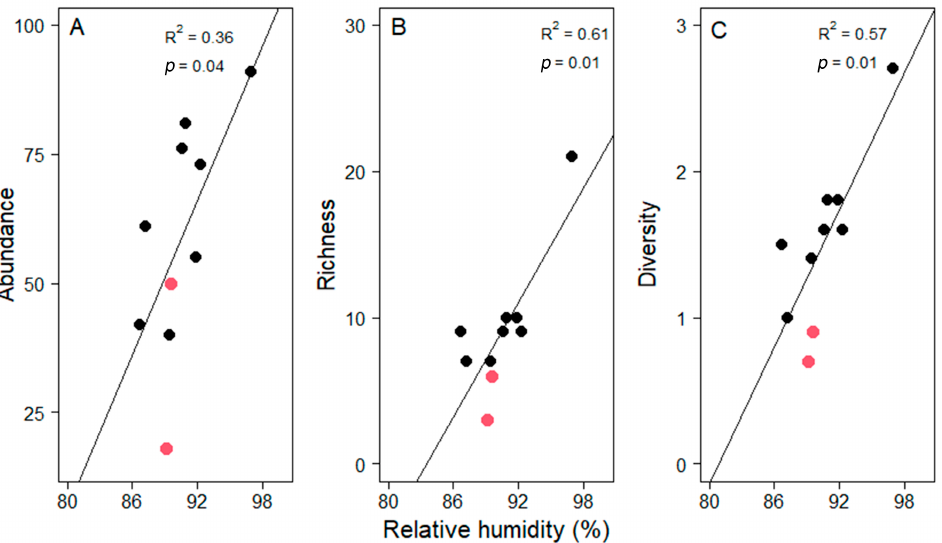
Figure 5. Variation in the average of ( A ) abundance, ( B ) richness and ( C ) diversity (as the Shannon index) of epiphyte assemblages in pasture trees ( n = 10 per plot) as a function of relative humidity along an elevational gradient in Gualaca district. Pastures at 870 and 1050 m a.s.l. are highlighted with red symbols. Coefficients of determination and p -values of regression analyses are given in each